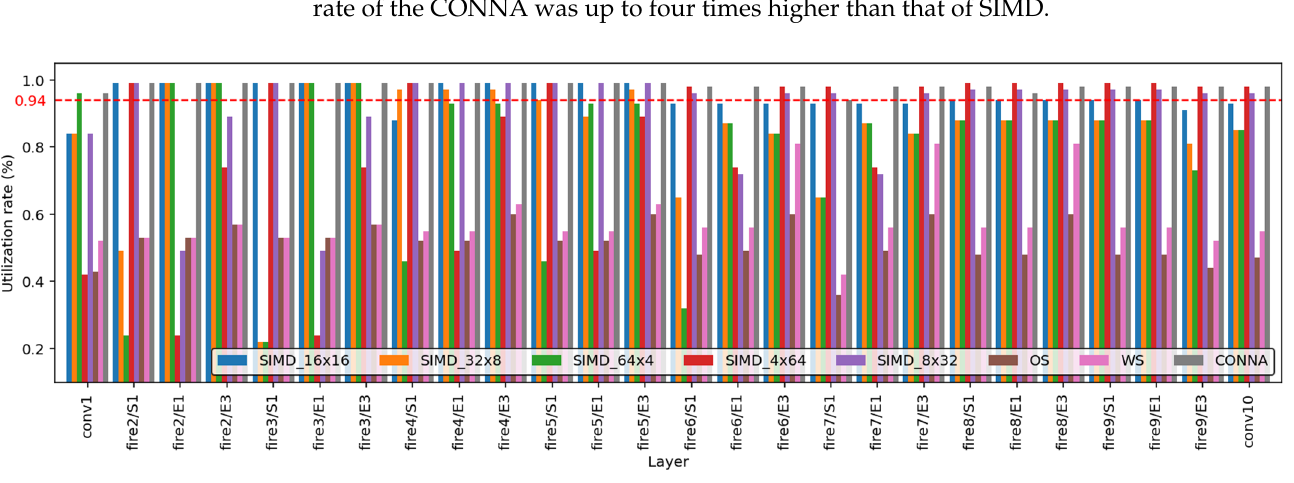
Figure 15. PE utilization rates of SIMD, OS-SA, WS-SA and CONNA for SqueezeNet v1.1. SIMD-based accelerators (16 × 16, 64 × 4, 32 × 8, 4 × 64, 8 × 32) were classified according SIMD-based accelerators (16 × 16, 64 × 4, 32 × 8, 4 × 64, 8 × 32) were